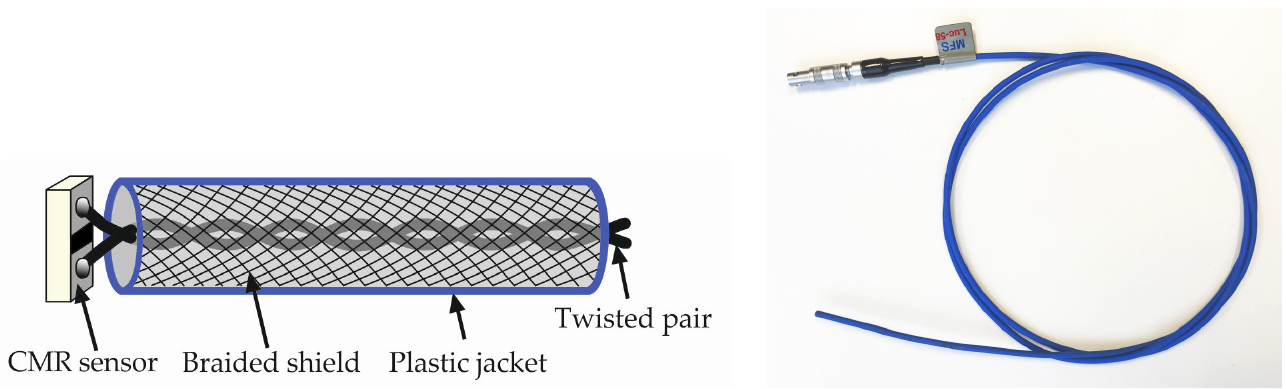
Figure 6. The cross-section ( left ) and picture of the sensor ( right ).